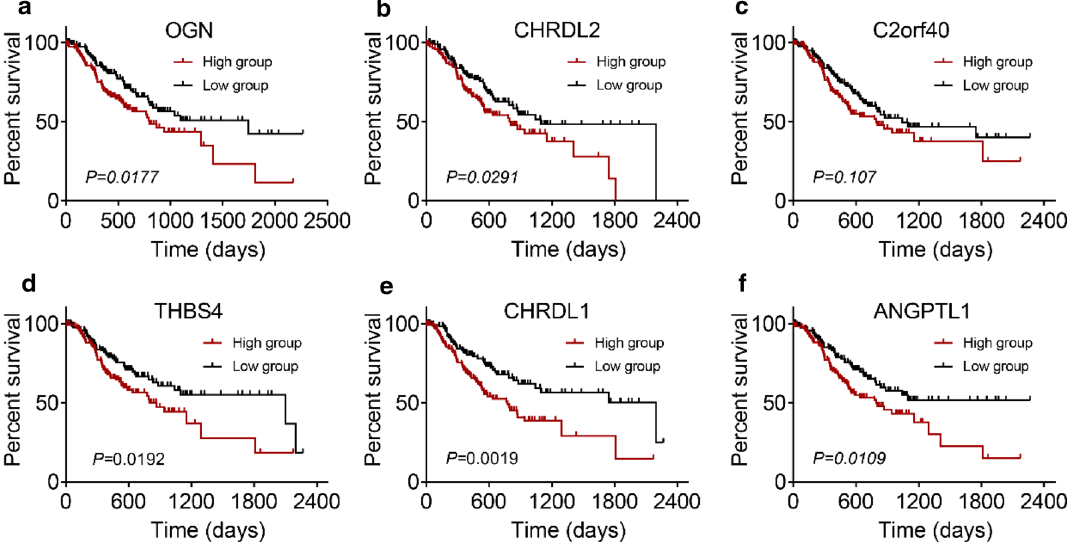
Fig. 3 Survival prognosis of six hub genes in high- and low- groups in GC patients using OncoLnc datasets. Kaplan–Meier survival analysis according to the expression of OGN ( a ), CHRDL2 ( b ), C2orf40 ( c ), THBS4 ( d ), CHRDL1 ( e ), and ANGPTL1 ( f ), respectively, were significant dif- ferences in GC